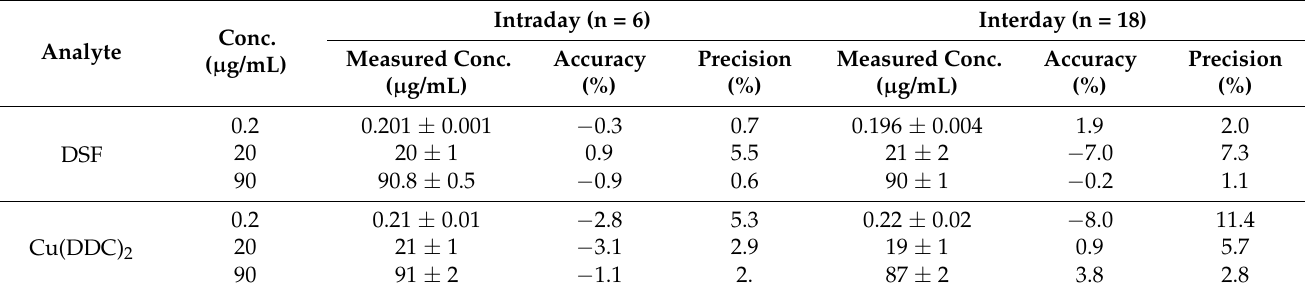
Table 7. Intraday and interday accuracy and precision. Results are expressed as mean ± SD.